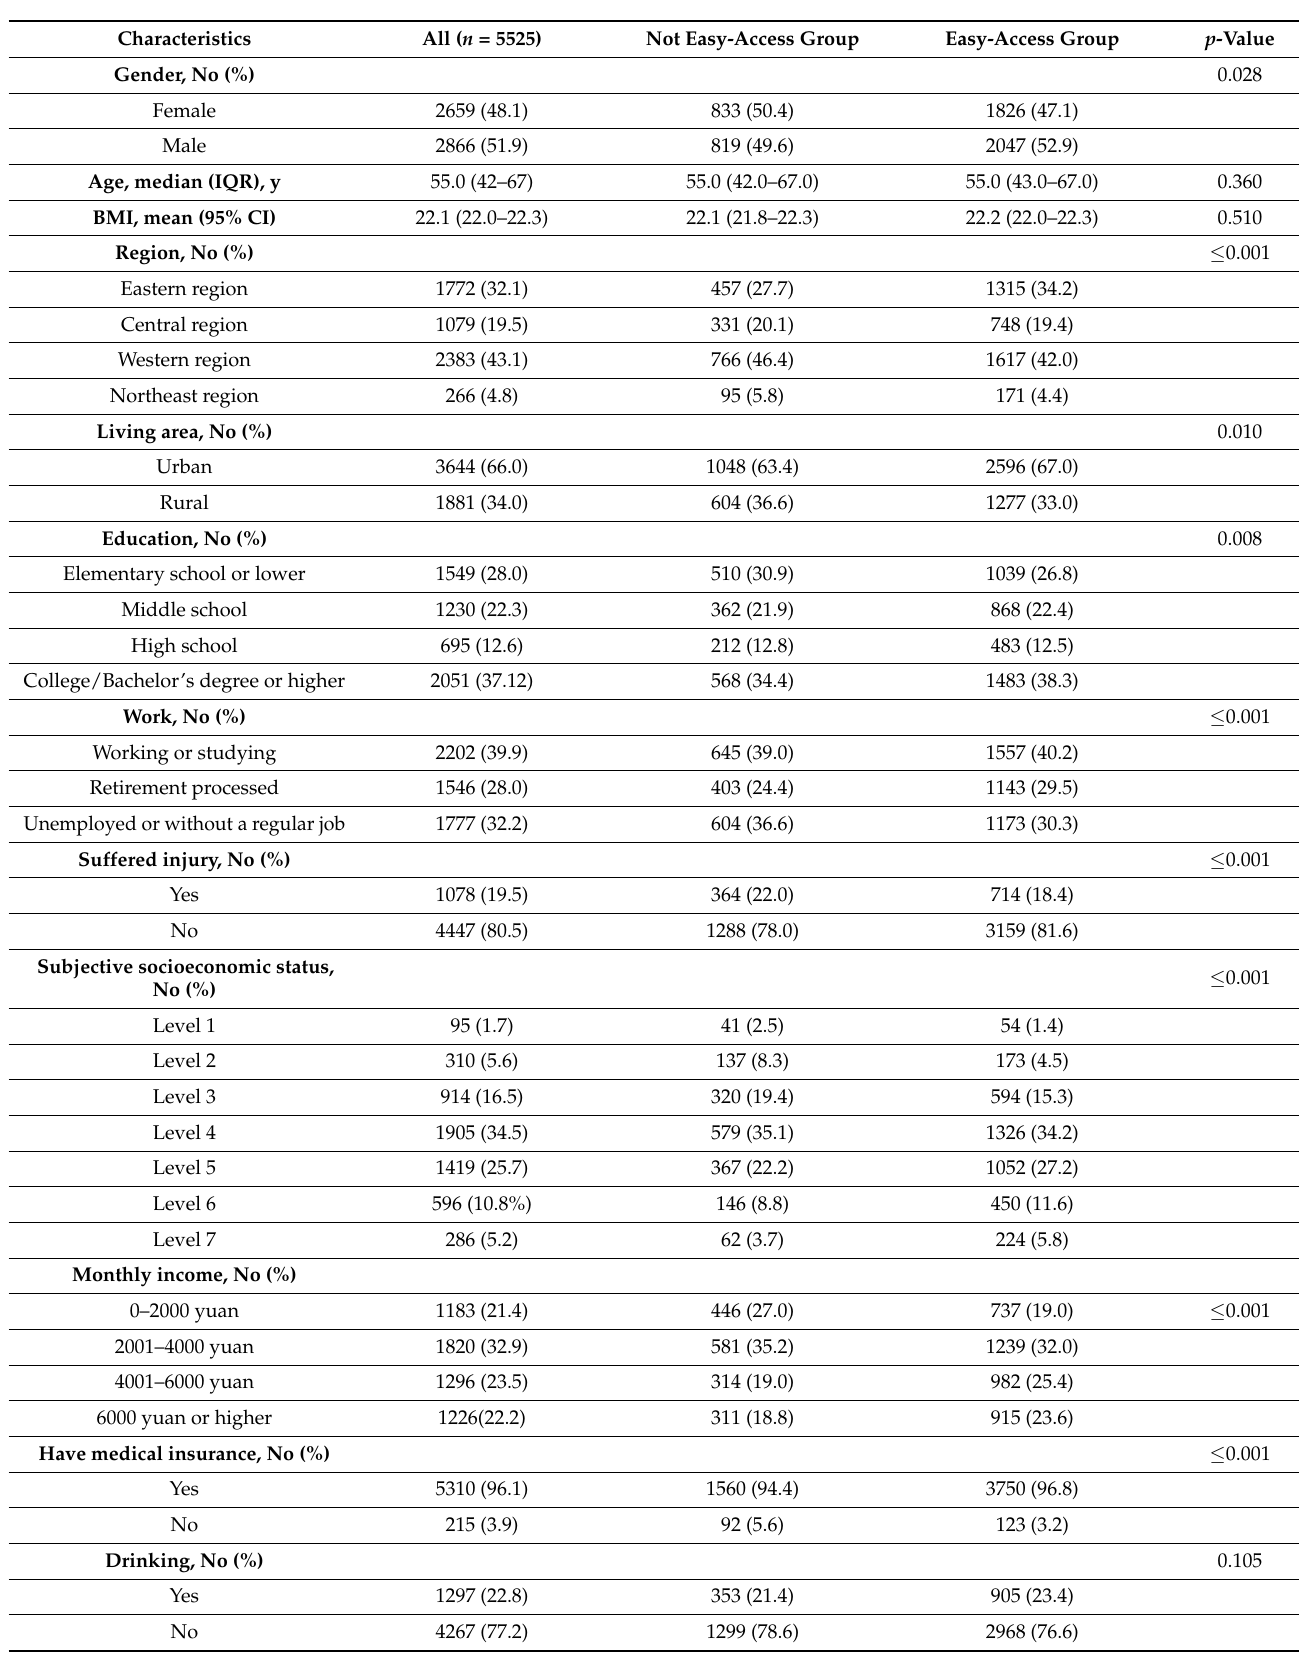
Table 1. Patients’ sociodemographic characteristics for the easy-access and not-easy-access groups with respect to CDM services provided by primary care